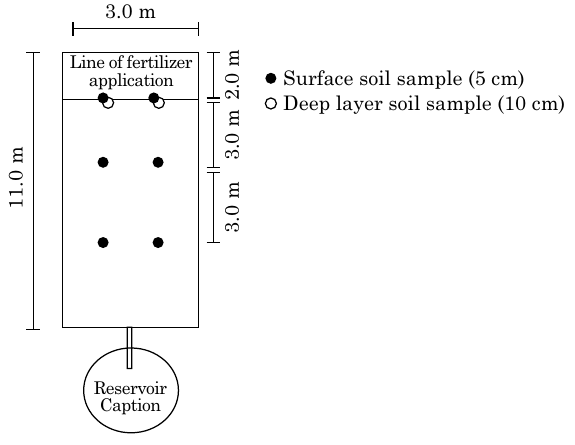
figure 1. diagram of the fertilizer application line and soil